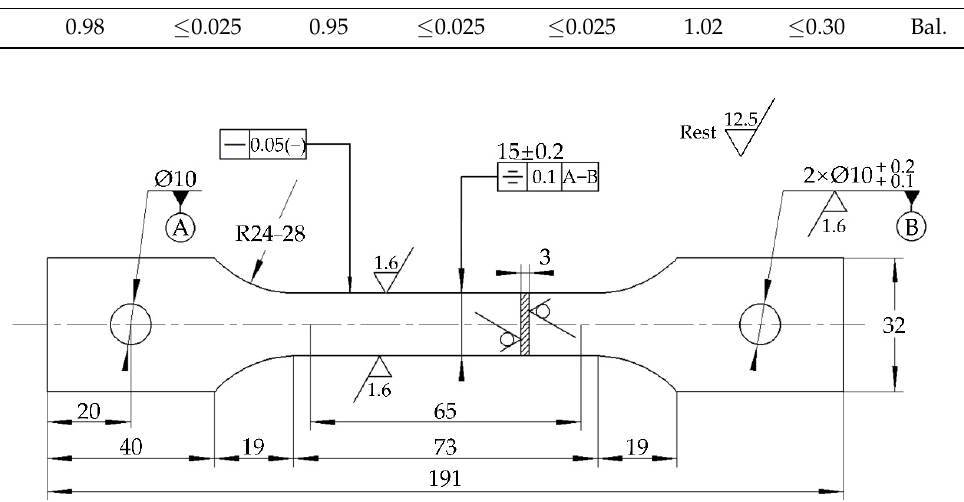
Figure 1. The dimensions of the tensile and fatigue specimens (unit: mm). Table 2. Chemical compositions of the simulated seawater, g/L.